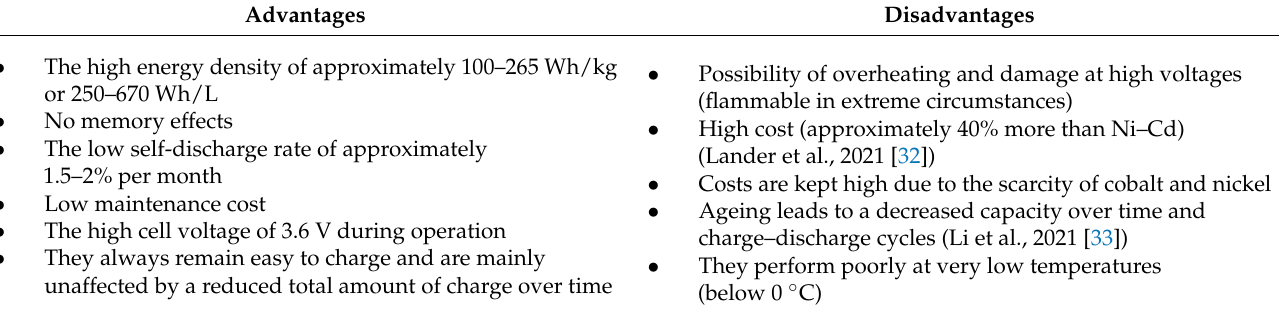
Table 1. Advantages and disadvantages of lithium-ion batteries.